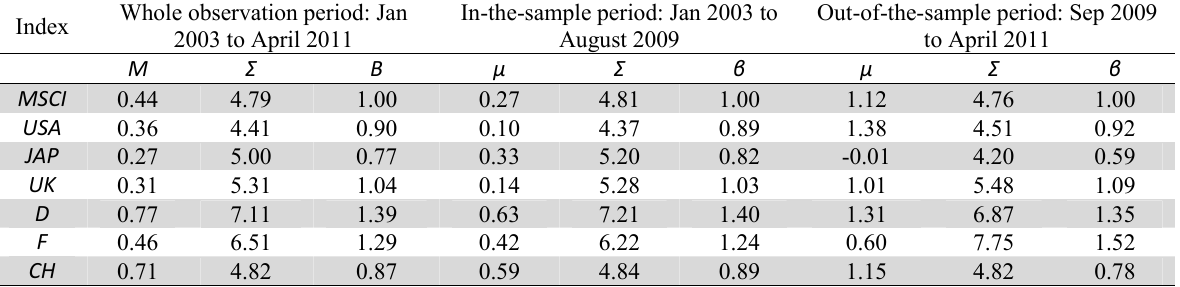
Risk/return characteristics of MSCI total return indices in terms of US$; All figures in